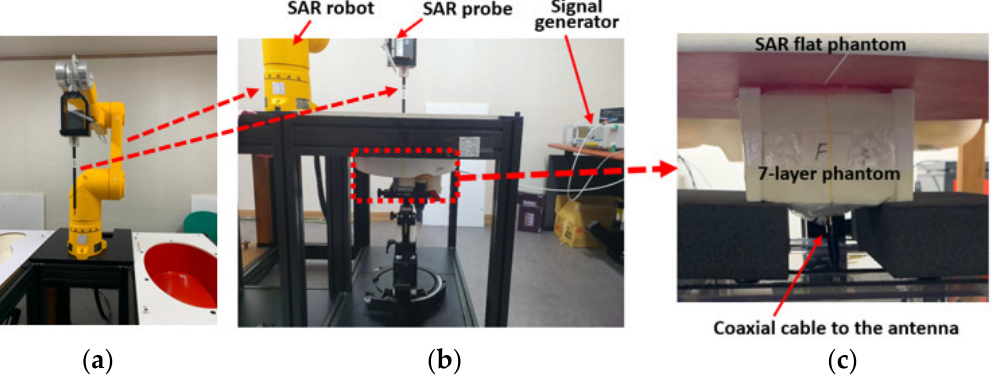
Figure 15. SAR measurement setup with DASY 5 SAR robot: ( a ) SAR robot with the probe, ( b ) whole measurement setup, and ( c ) antenna